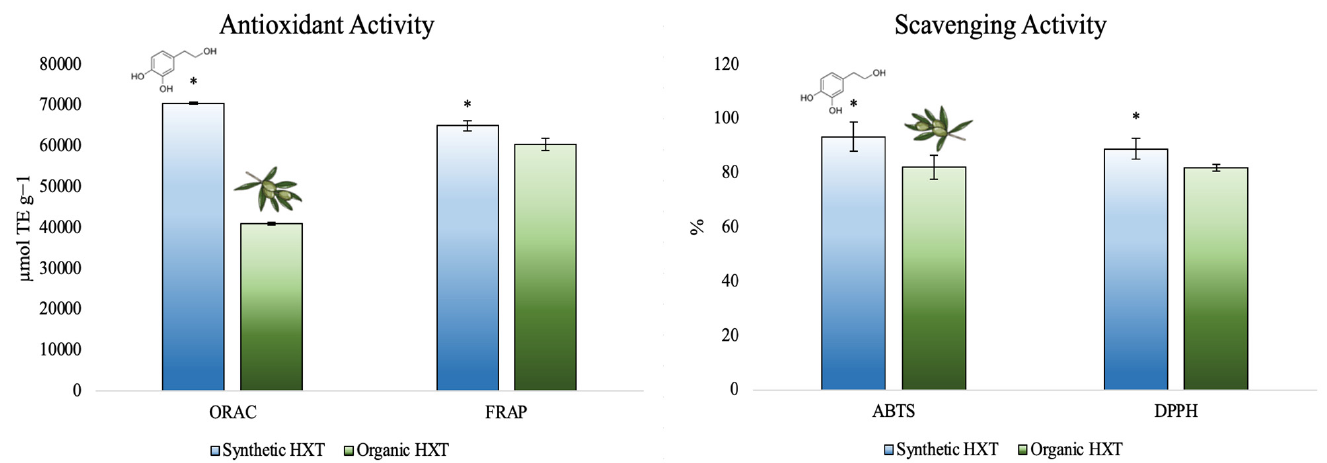
Figure 2. Total antioxidant capacity of synthetic and organic HXT [58]. * Denotes significant differences between synthetic and organic HXT.